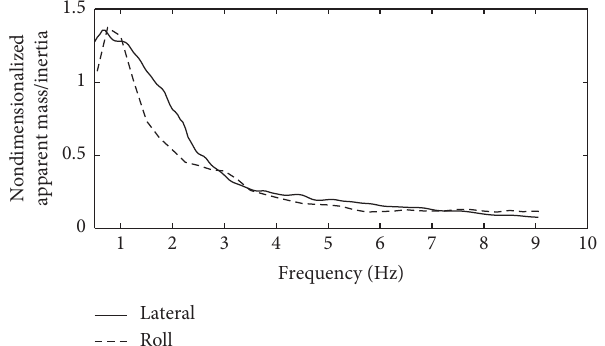
Figure 9: Nondimensionalized apparent inertia of seated human body under roll and lateral